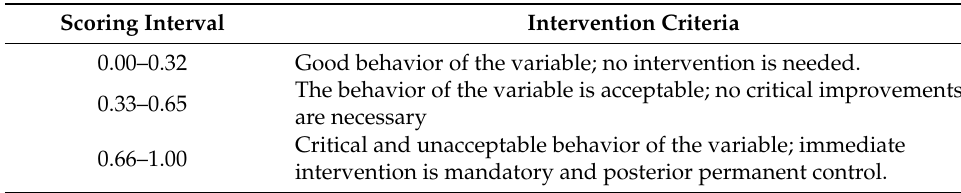
Table 2. Intervals of risk variables and intervention